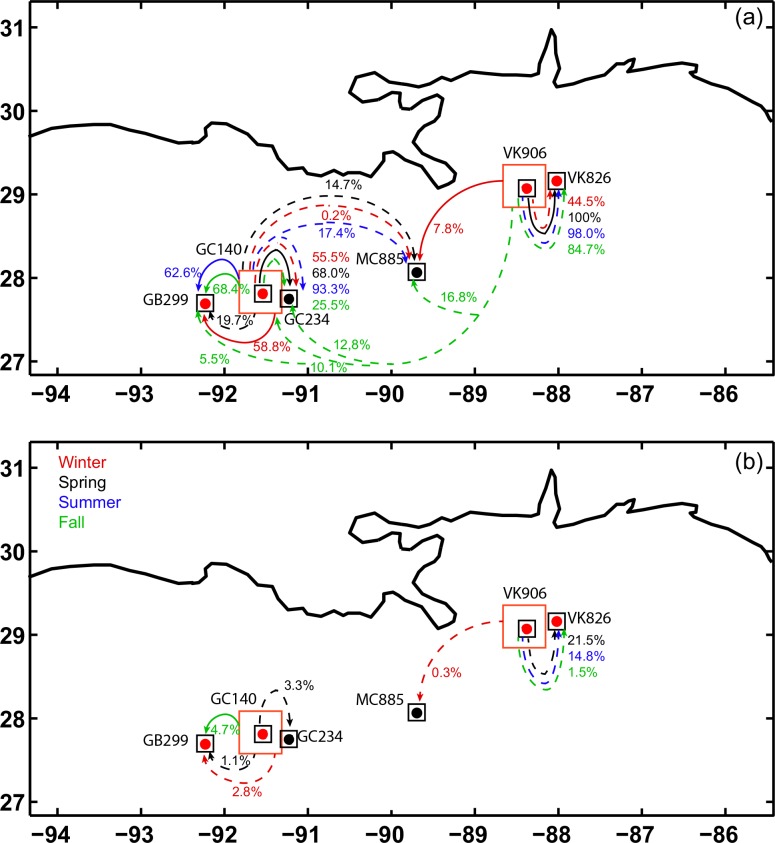
Connectivity diagrams VK906 and GB140.As in Fig 8 but for larvae released at VK906 and GC140.